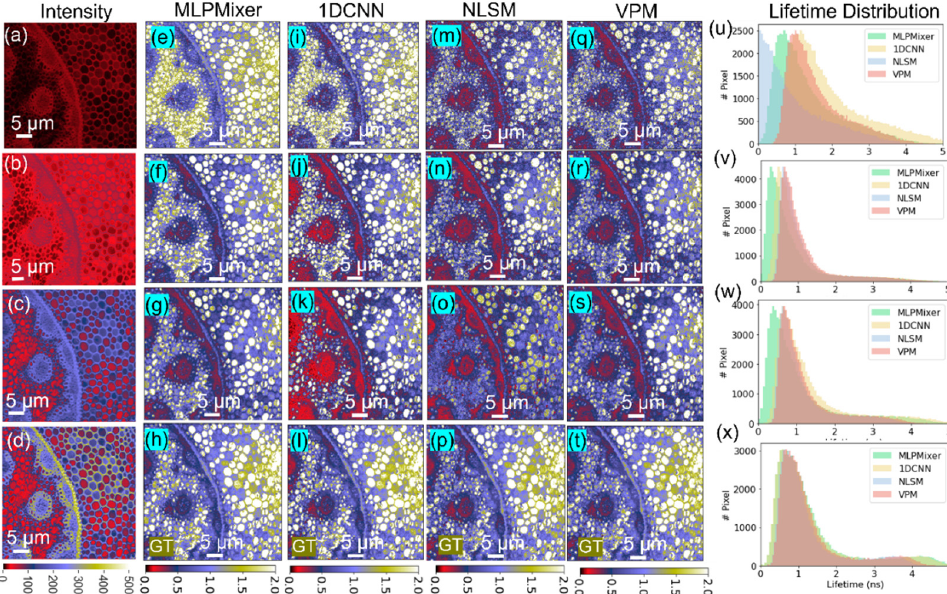
Figure 5. Two-photon FLIM experiments of Convallaria majalis cells. ( a – d ) Intensity images under different SNRs (3 s, 15 s, 30 s, and 90 s acquisition time). Lifetime images recovered from ( e – h ) the